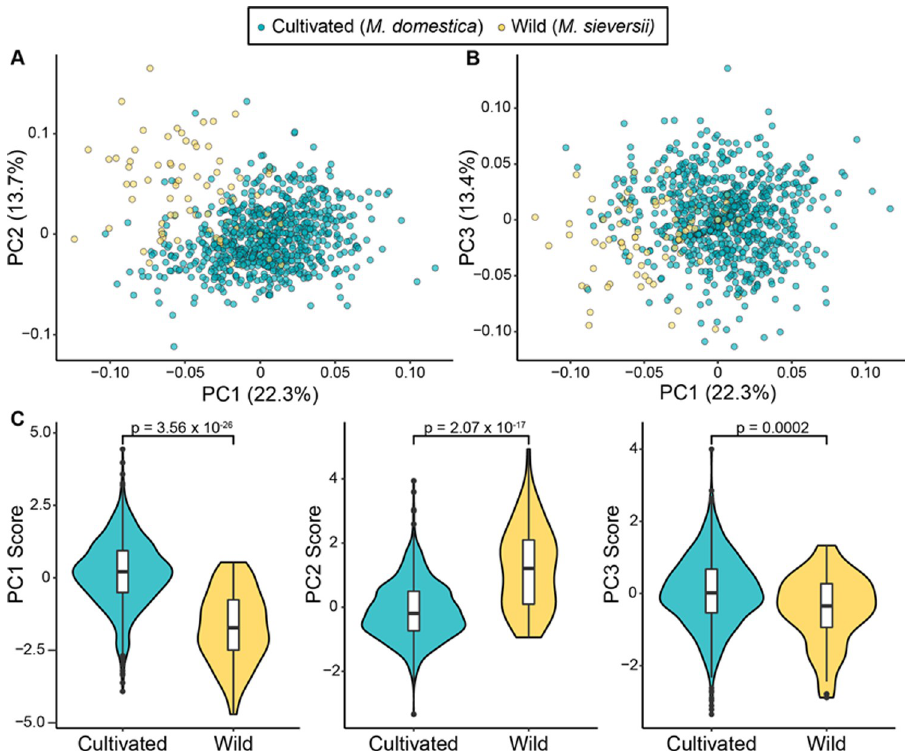
Fig 1. PCA of ten phenotypes in wild (N = 79) and cultivated apples (N = 801). A) PC1 vs PC2. B) PC1 vs PC3. The proportion of the variance explained by each PC is shown in parentheses on each axis. C) The difference between wild and cultivated apples for PCs 1, 2 and 3 are shown as violin plots. P values from a Wilcoxon test comparing PC values between cultivated and wild apples are shown for each of the first three PCs.